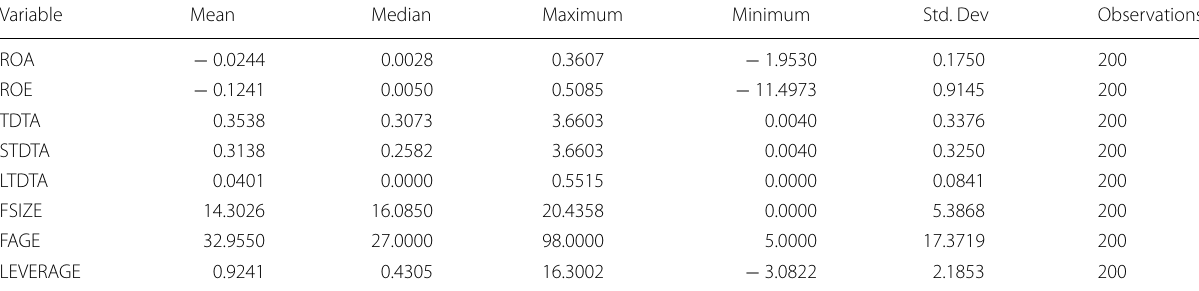
Above is the table of descriptive statistics, which is showing the data that was collected from the 40 Jordan listed firms. It can be seen that the data lie in between the valid maximum and minimum value range. Moreover, the standard deviation values are low and show that the data is least skewed